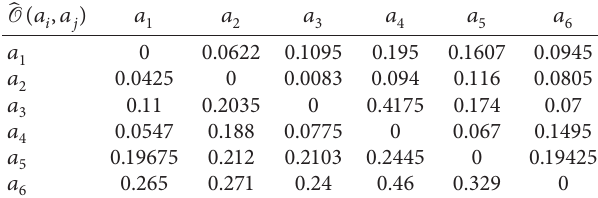
Table 2: The overall preference indices among drugs.